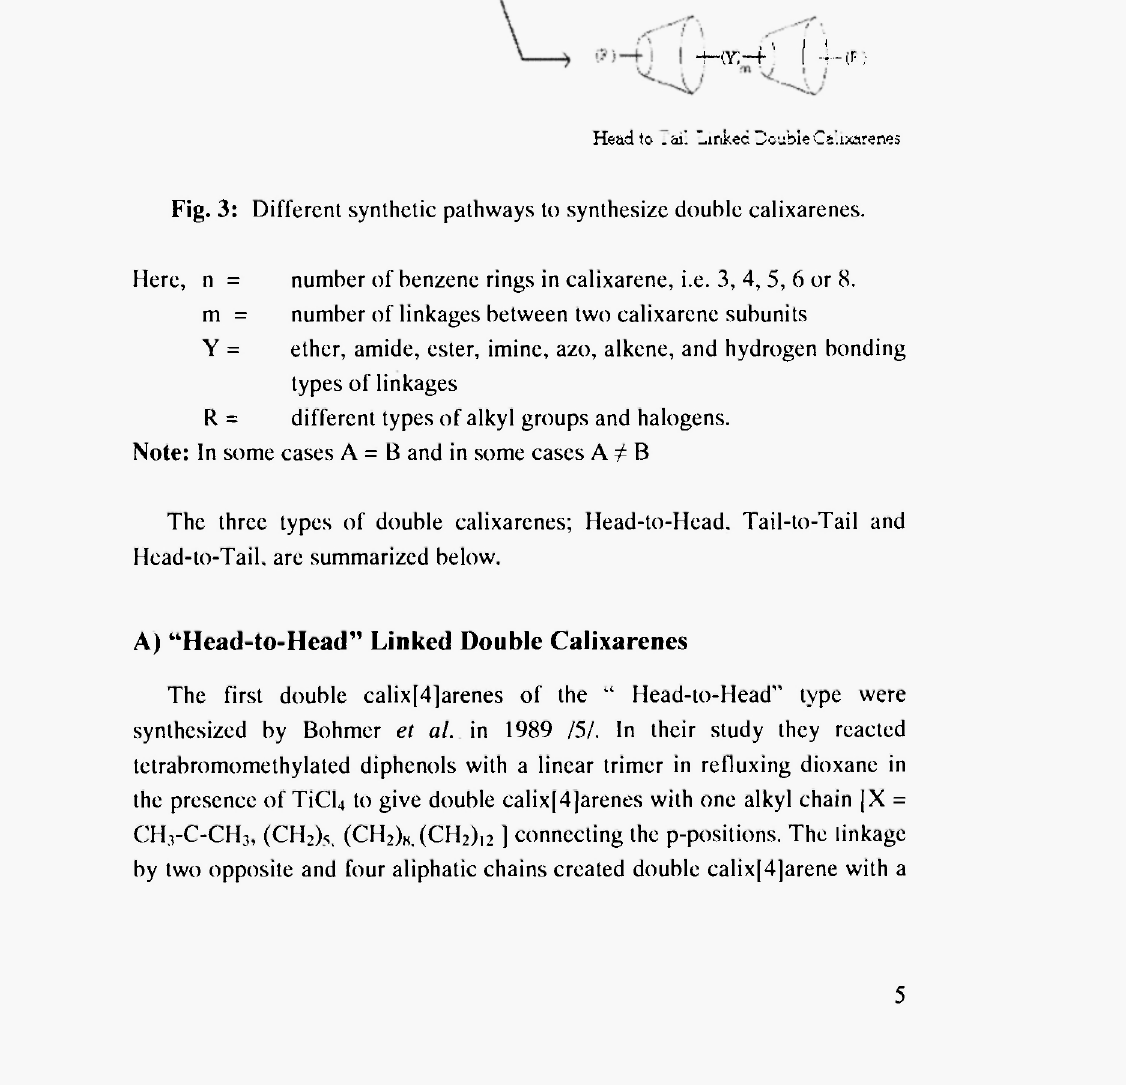
Fig. 3: Different synthetic pathways to synthesize double